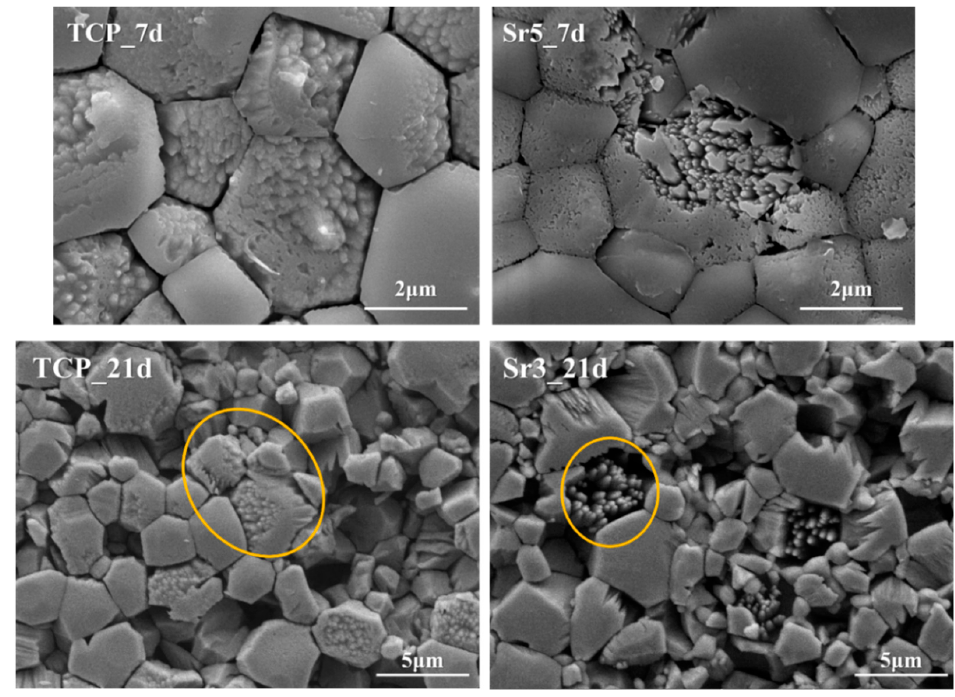
Figure 13. Magnified SEM images of TCP, Sr3, and Sr5 samples.